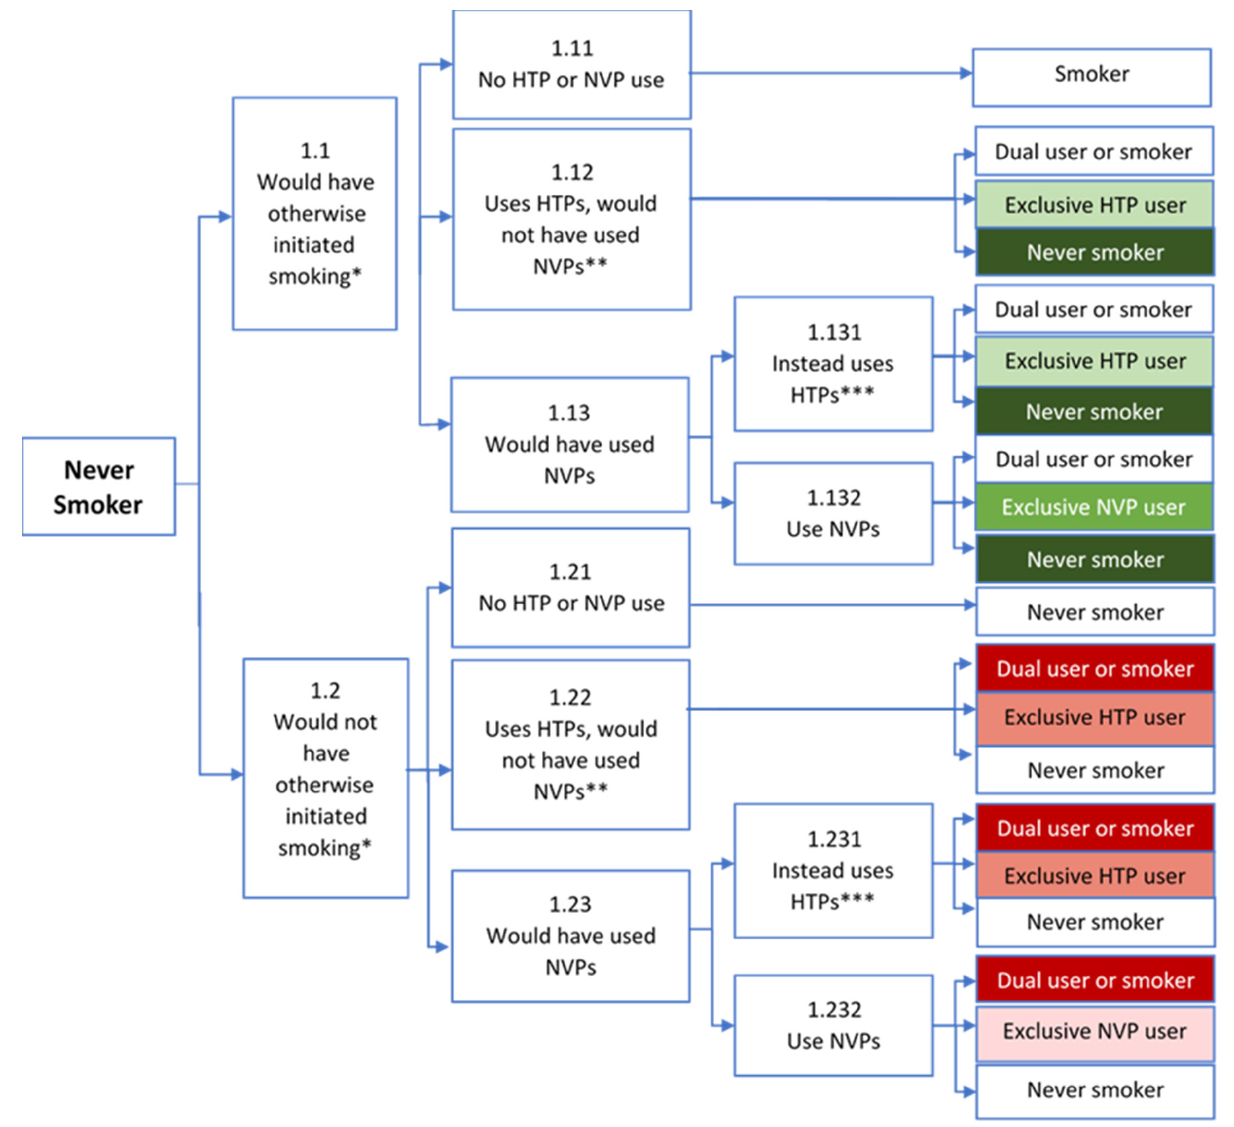
Figure 1. Public Health Impact of NVP and HTP Use Among Former Smokers. Notes: HTP = Heated Tobacco Product, NVP = Nicotine Vaping Product. * Based on the counterfactual of whether smoking initiation would have occurred in the absence of both HTPs and NVPs. ** HTPs are a more desirable alternative to NVPs, e.g., tried NVPs and not found desirable or satisfactory. *** Would have otherwise preferred NVPs, but diverted from use due to industry behavior or govern- ment policy. Green indicates public health benefit; Red indicates public health loss. Darker shades indicate a greater